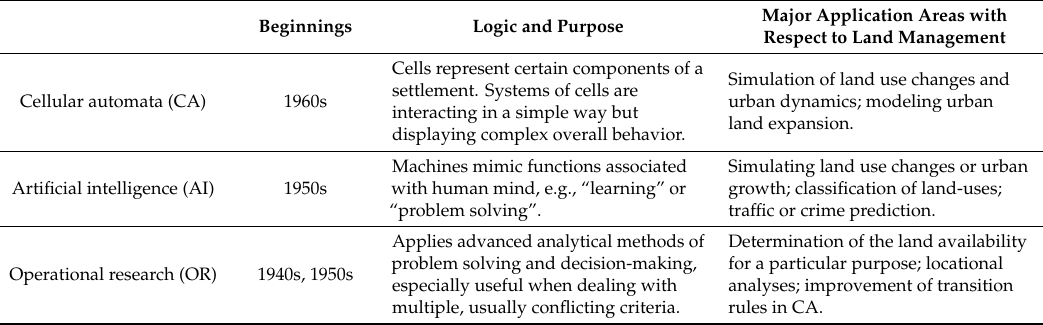
Table 1. Brief characteristic of the selected